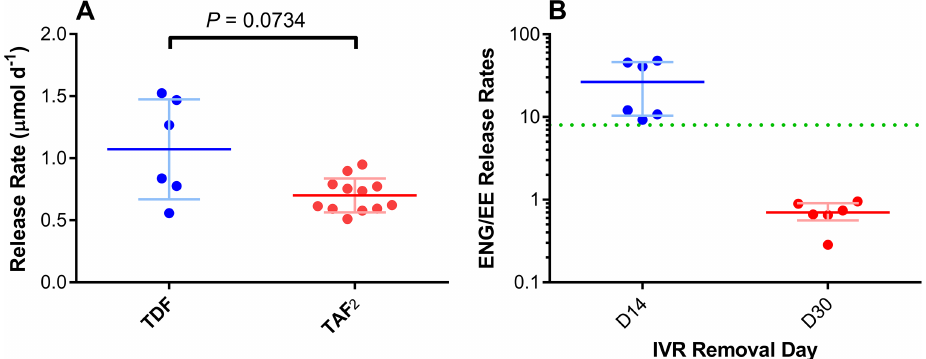
Fig 4. In vivo IVR drug releaserates in the contextof previous studies. (A) Molardaily in vivo release of TDF froma previouspod-IVR study in pigtailed macaques [39]comparedto TAF 2 releaseratein the presentstudy. An unpaired t test withWelch’scorrection showsthat whilethe releaseratesarenot statistically significantly different( P = 0.0734),theyaresimilar,withthe meanTAF 2 releaserate (redhorizontalbar)being lowerthan themeanTDF releaserate(bluehorizontalbar)from theTDF-FTC pod-IVRs. Eachcirclecorresponds to anindividualdatum;paleerrorbars correspondto standarddeviationsfrom themean.(B) PairedENG:EE